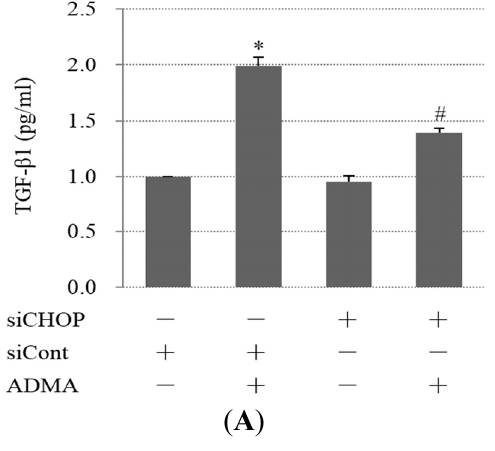
Figure 6. ADMA-induced TGF- β 1 expression through ER stress and inhibition by QC treatment. ( A ) GEnCs transfected with siRNA were exposed for 24 h to 100 μ M ADMA. TGF- β 1 levels were measured by ELISA (mean ± SD, n = 3); ( B ) GEnCs were pretreated with 10 μ M SP600125 for 30 min and then exposed to 100 μ M ADMA for 24 h. TGF- β 1 levels were measured by ELISA (mean ± SD, n = 3); and ( C ) GEnCs were treated for 1 h in the presence or absence of 20 μ M QC and then incubated with 100 μ M ADMA for 24 h. Culture supernatants were collected and analyzed for TGF- β 1 levels using an ELISA kit. p < 0.05 by ANOVA was considered significant. * different from controls ( p < 0.05); # different from ADMA-stimulated controls ( p <